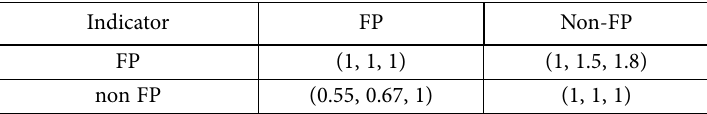
Table 6. Fuzzy pair-wise comparison matrix for the main-criteria FP, non-FP